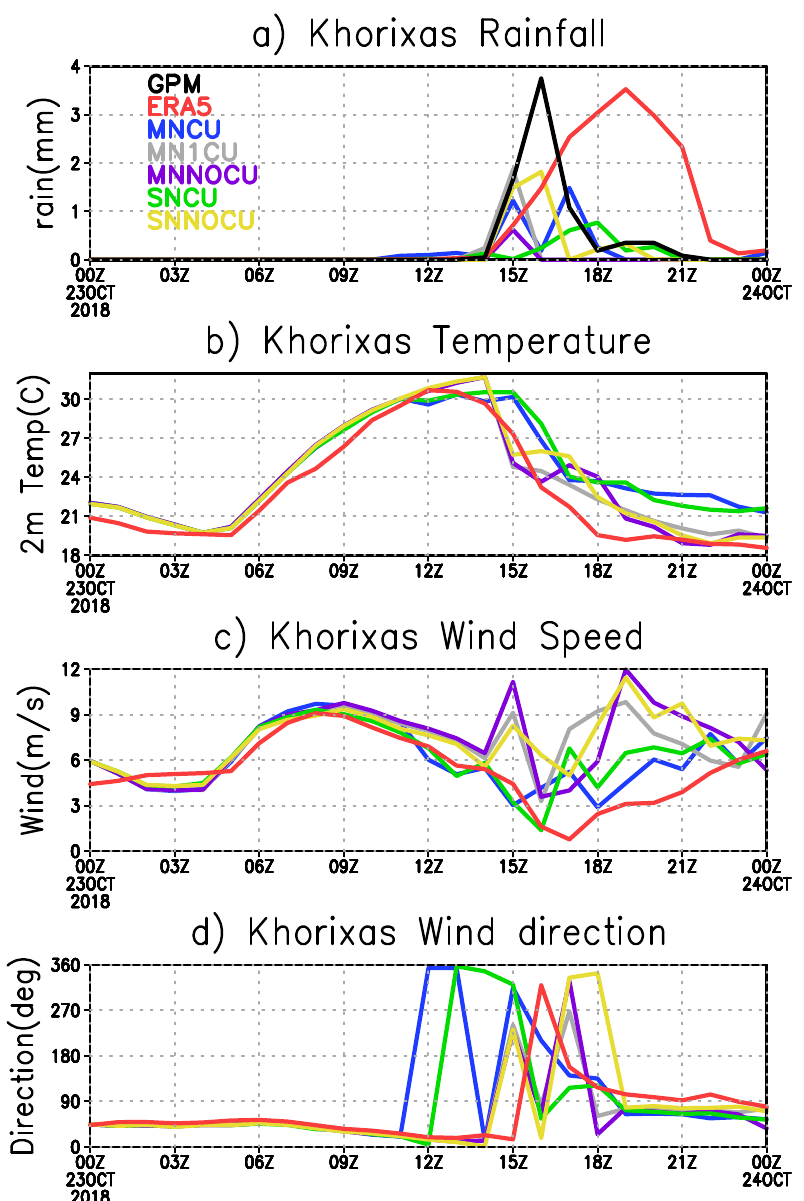
Figure 5. ( a ) shows hourly simulated by different WRF configurations and the predicted ERA5 rainfall, as well as GPM rainfall estimate. The remaining plots show hourly ( b ) temperature, ( c ) wind speed and ( d ) wind direction at Khorixas from 00 h 00 UTC on 23 October to 00 h 00 UTC on 24 October.